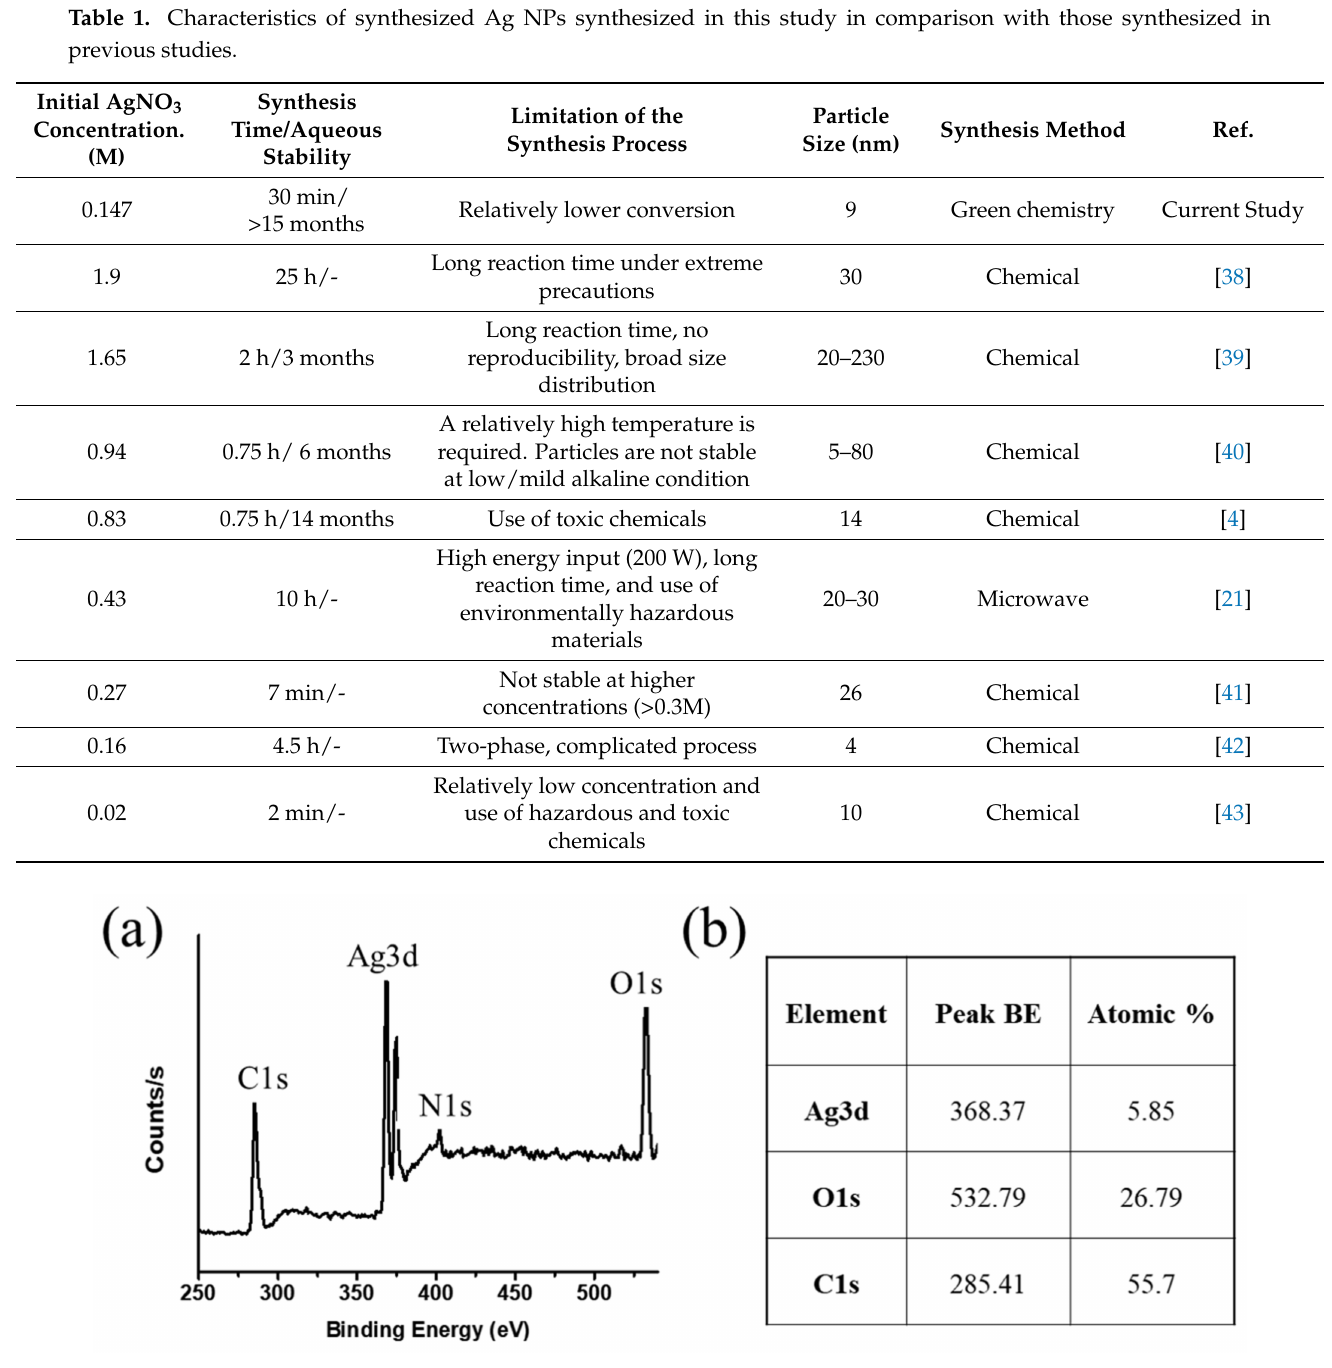
Figure 5. ( a ) X-ray photoelectron (XPS) analysis of Ag NPs-PTA; ( b ) elemental composition of synthesized silver